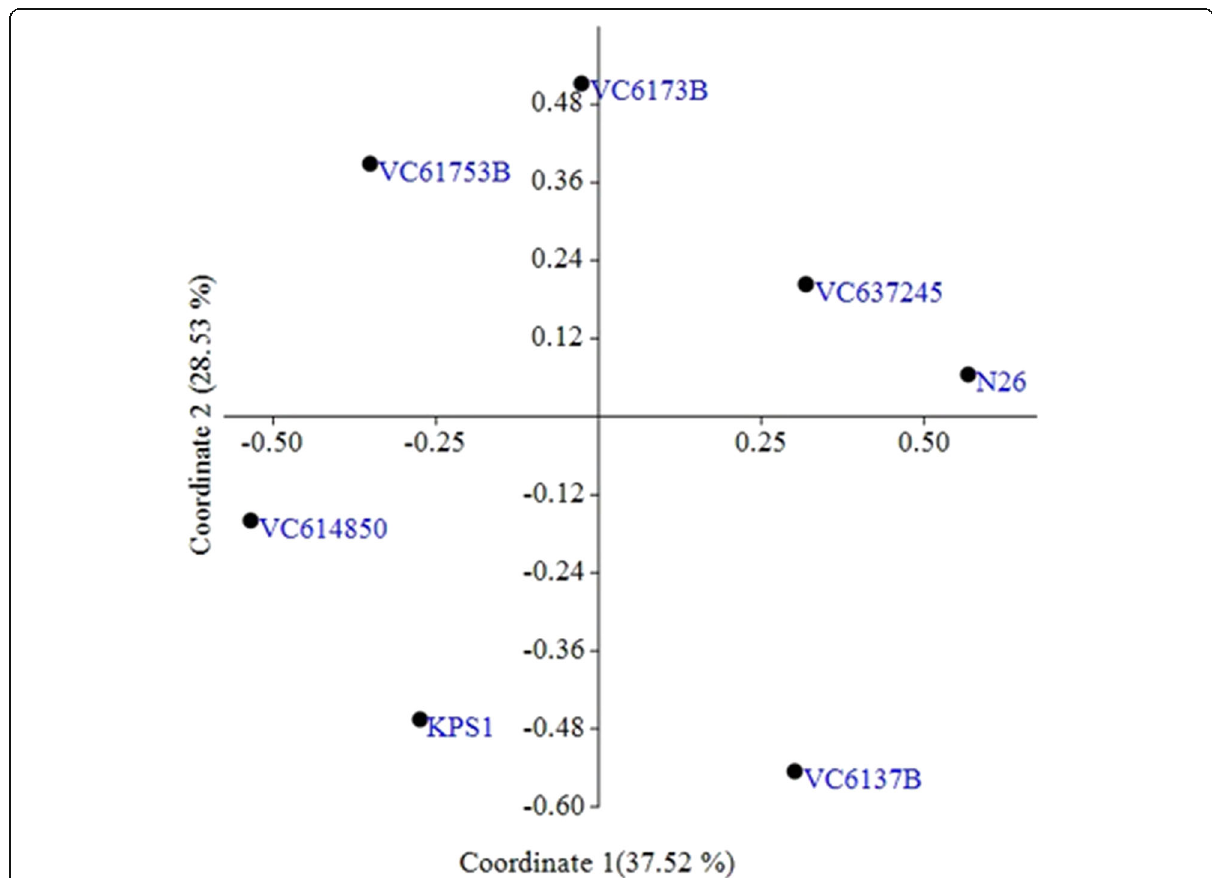
Fig. 4 Principal coordinate analysis of Vigna radiata based on the ten simple sequence repeat markers. The percentage variations for the first two coordinates are 37.52% and 28.53%,